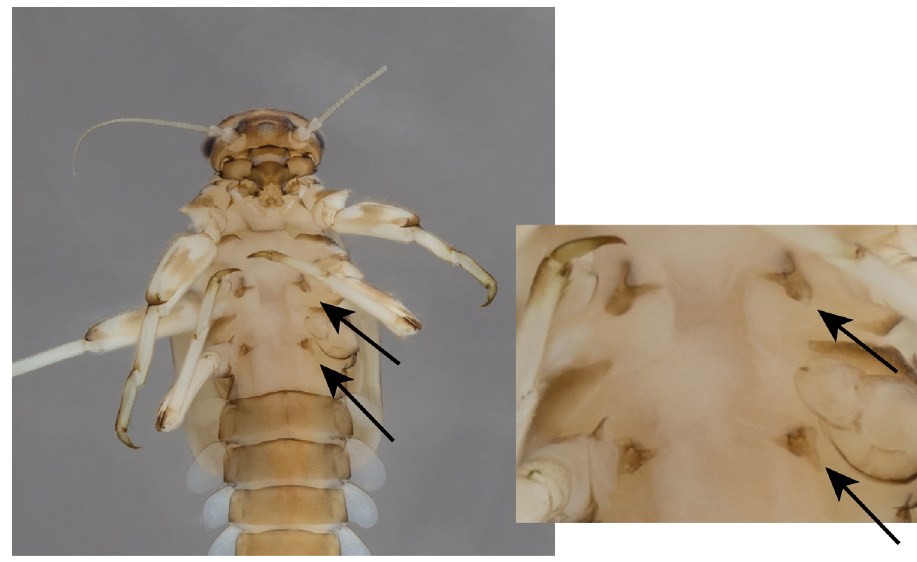
Figure 9. Baetis pacis sp. n., nymph, ventral, showing protuberances next to coxae (arrows), which are typical to nymphs of B. pacis and B. golanensis